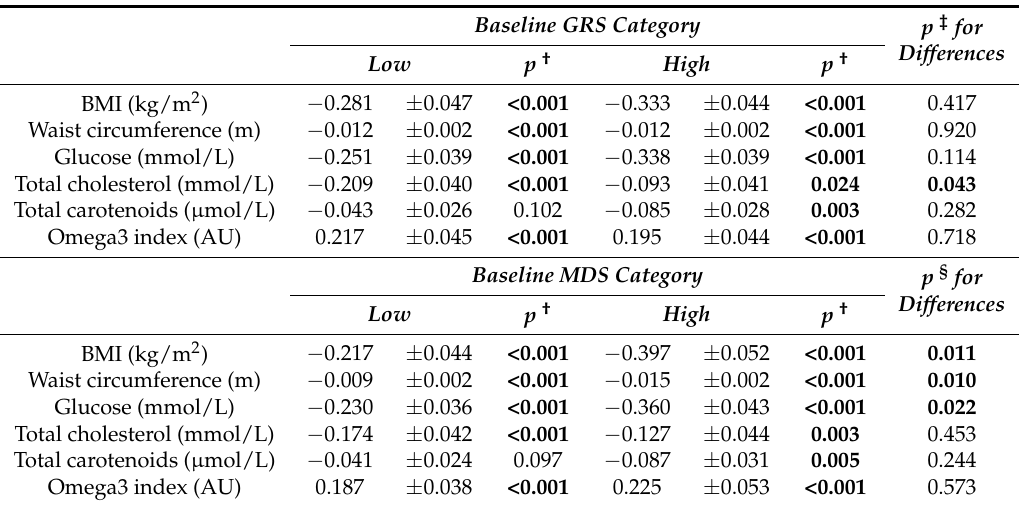
Table 2. Anthropometrical and biochemical changes at 6 months into the Food4Me intervention, depending on GRS and MDS categories at